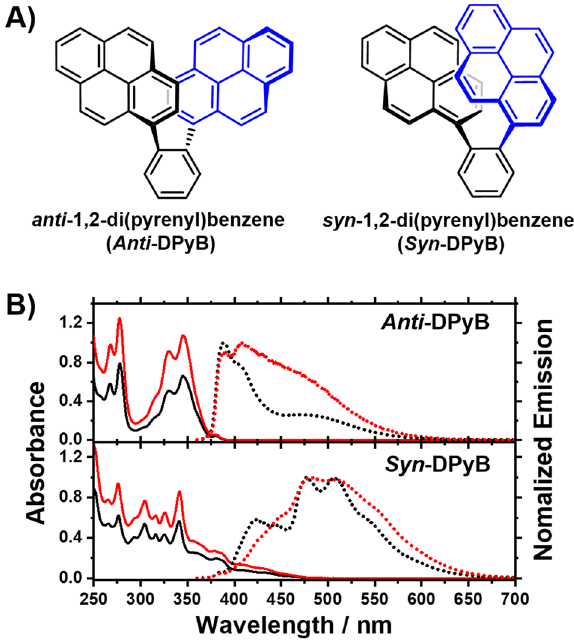
Fig. 1 Structures and UV – visible absorption (solid line) and emission spectra (dotted line). A Geometric isomers of anti -1,2-di(phenyl)benzene ( Anti -DPyB) and syn -1,2-di(phenyl)benzene ( Syn -DPyB). B UV – visible absorption spectra of Anti -DPyB and Syn -DPyB in n -hexane (black) and acetonitrile (red). Emission spectra of Anti -DPyB and Syn -DPyB in n -hexane (black) and acetonitrile (red) ( λ ex = 345